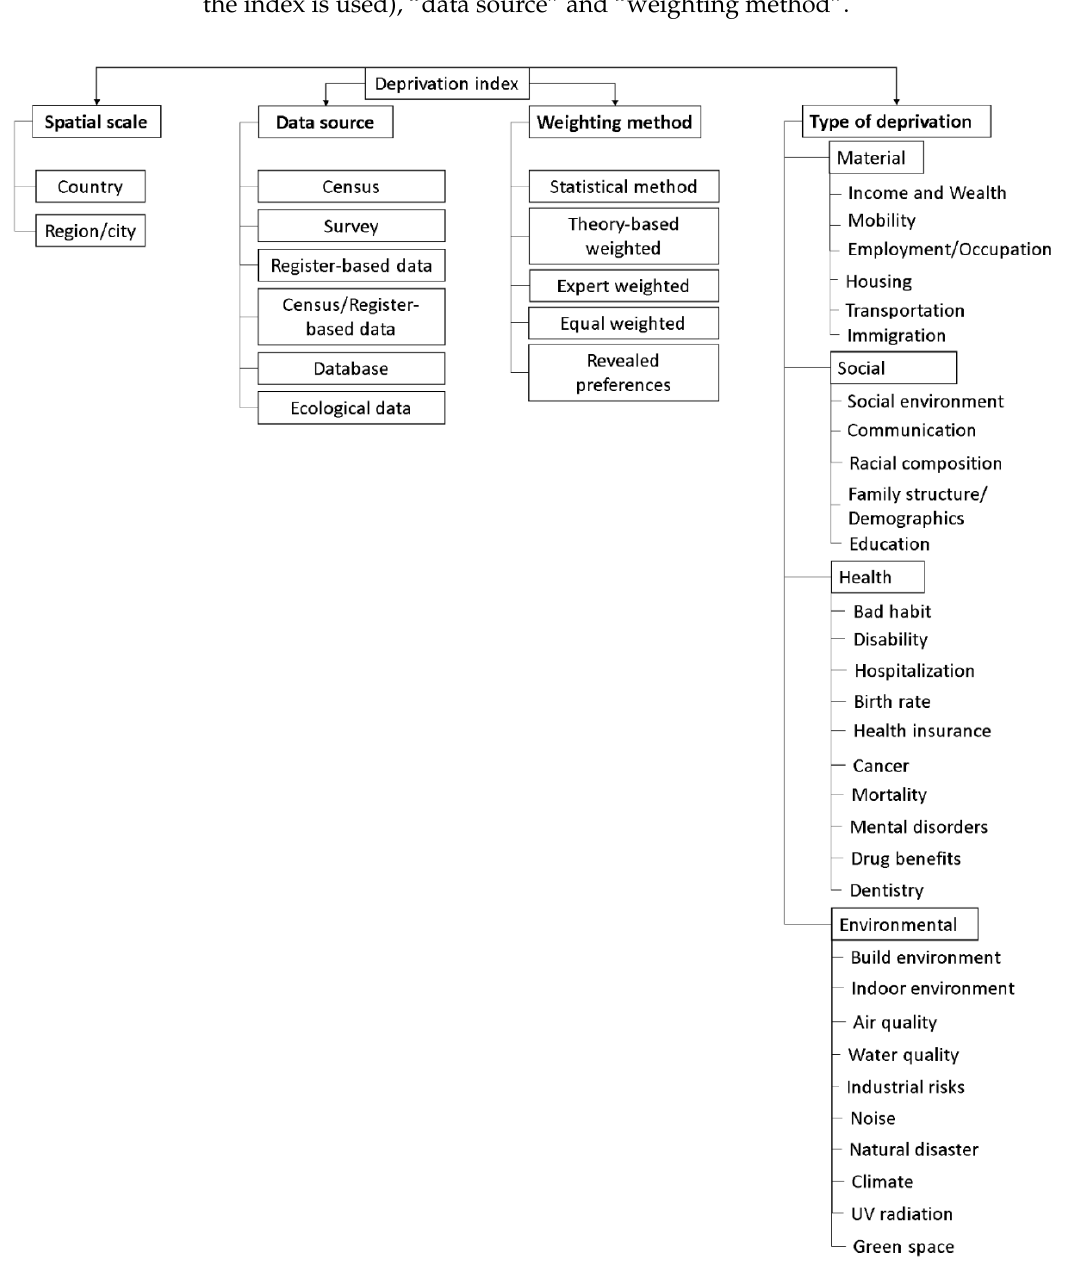
Figure 2. Taxonomy of deprivation indices.